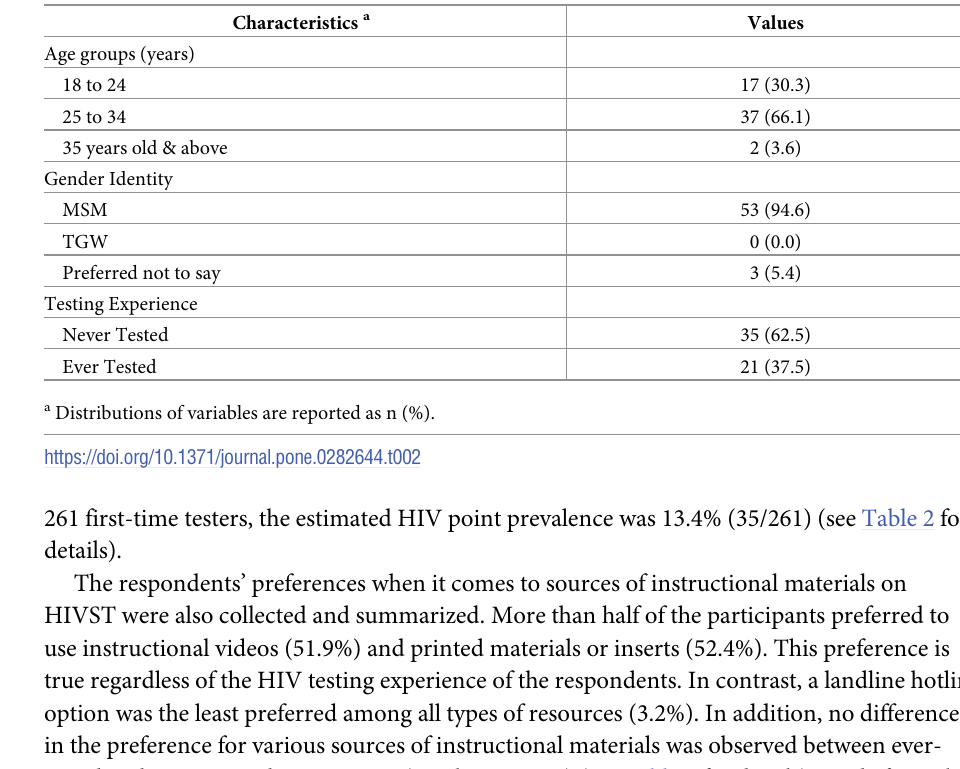
Table 2. Characteristics of reactive respondents linked to further testing (n = 56).